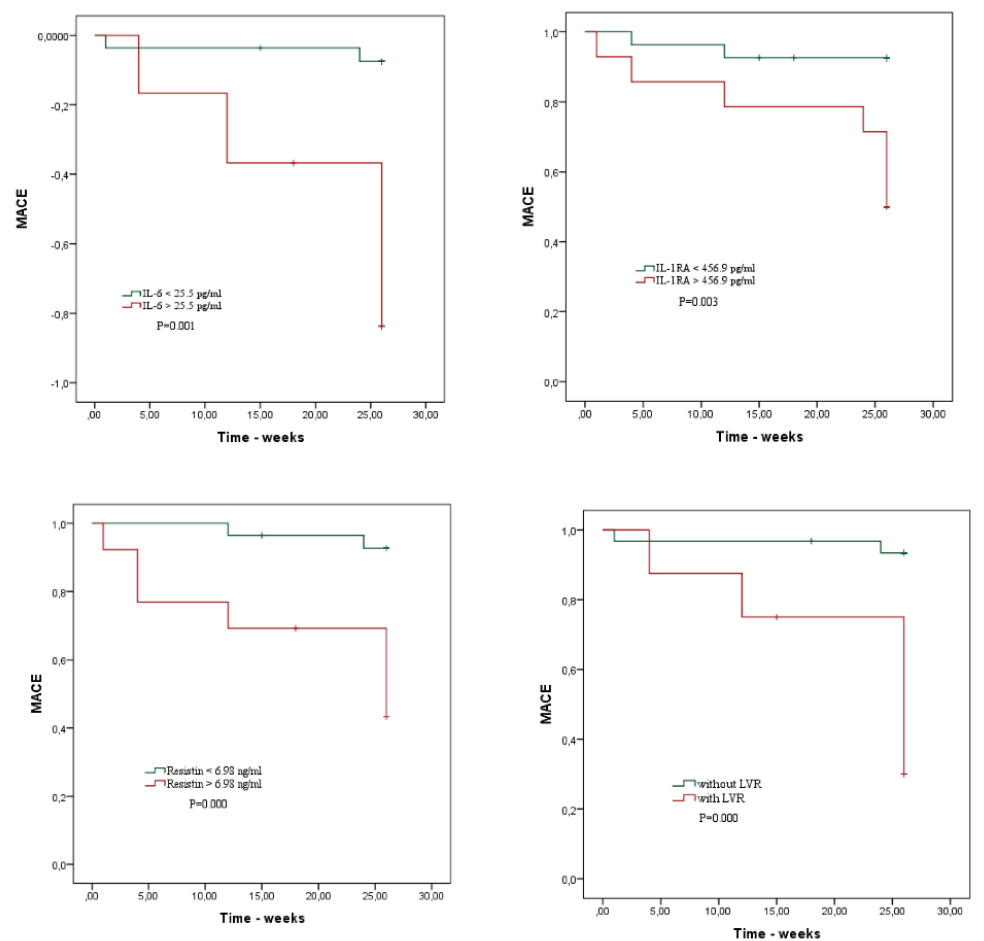
Figure 4. Kaplan-Meyer analysis-Kaplan-Meier curves showing the risk of MACE stratified by IL-6, IL-1RA, resistin and LVR. IL-6, IL-1RA and resistin were dichotomized according to the optimal cut-off value, calculated by ROC analysis.